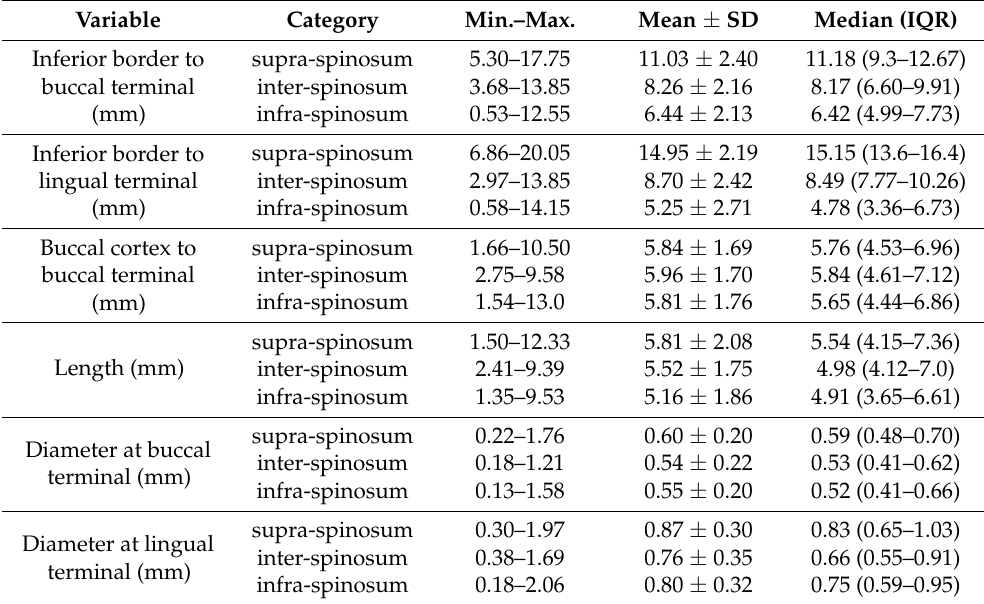
Table 2. Descriptive analysis of the studied cases according to position, length, and diameter. Variable Category Min.–Max. Mean ± SD Median